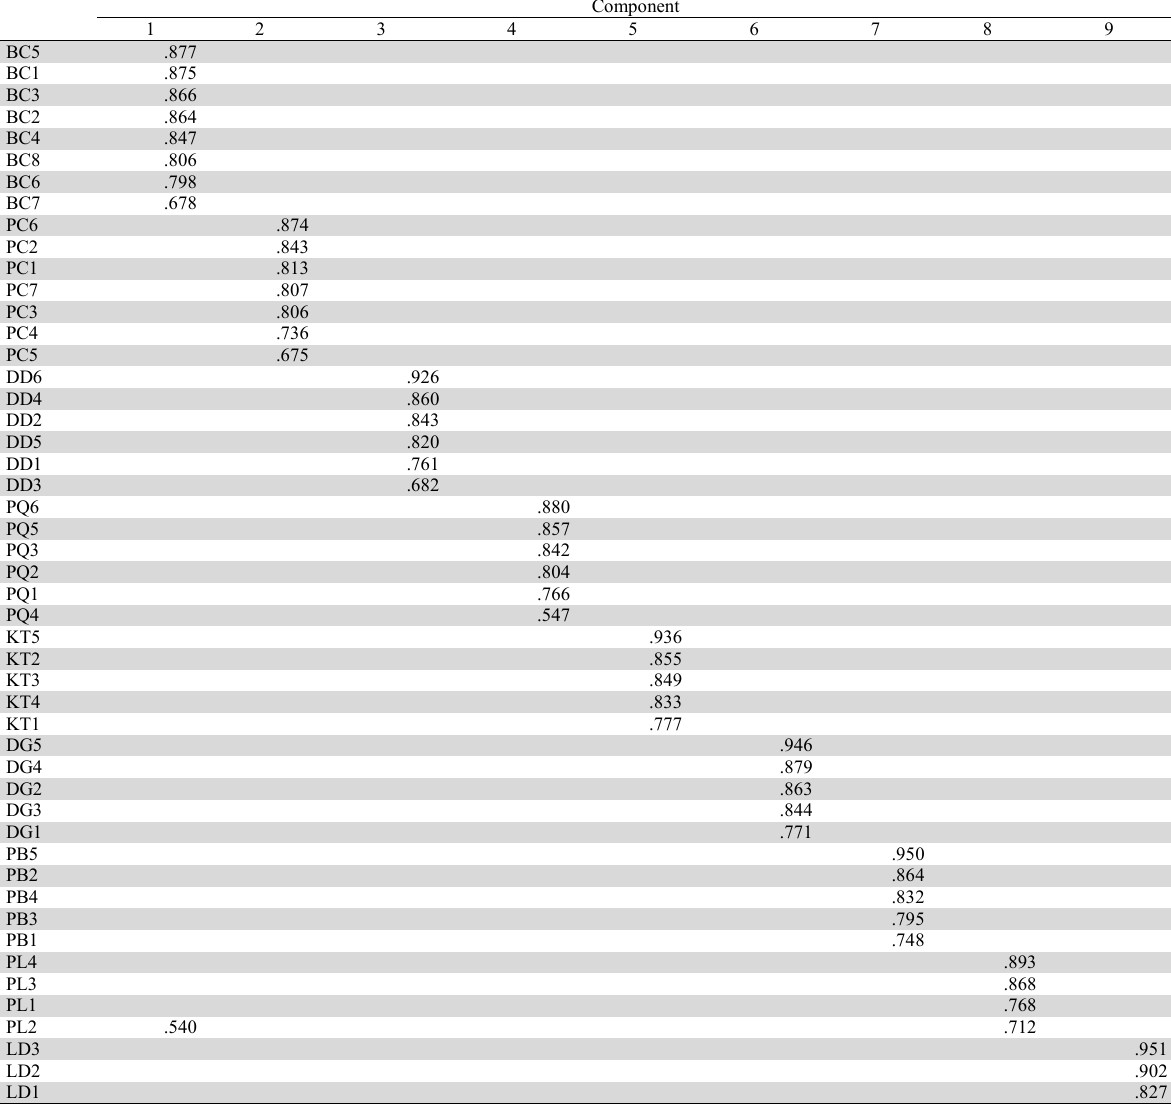
Rotated Component Matrix a Source: collected from